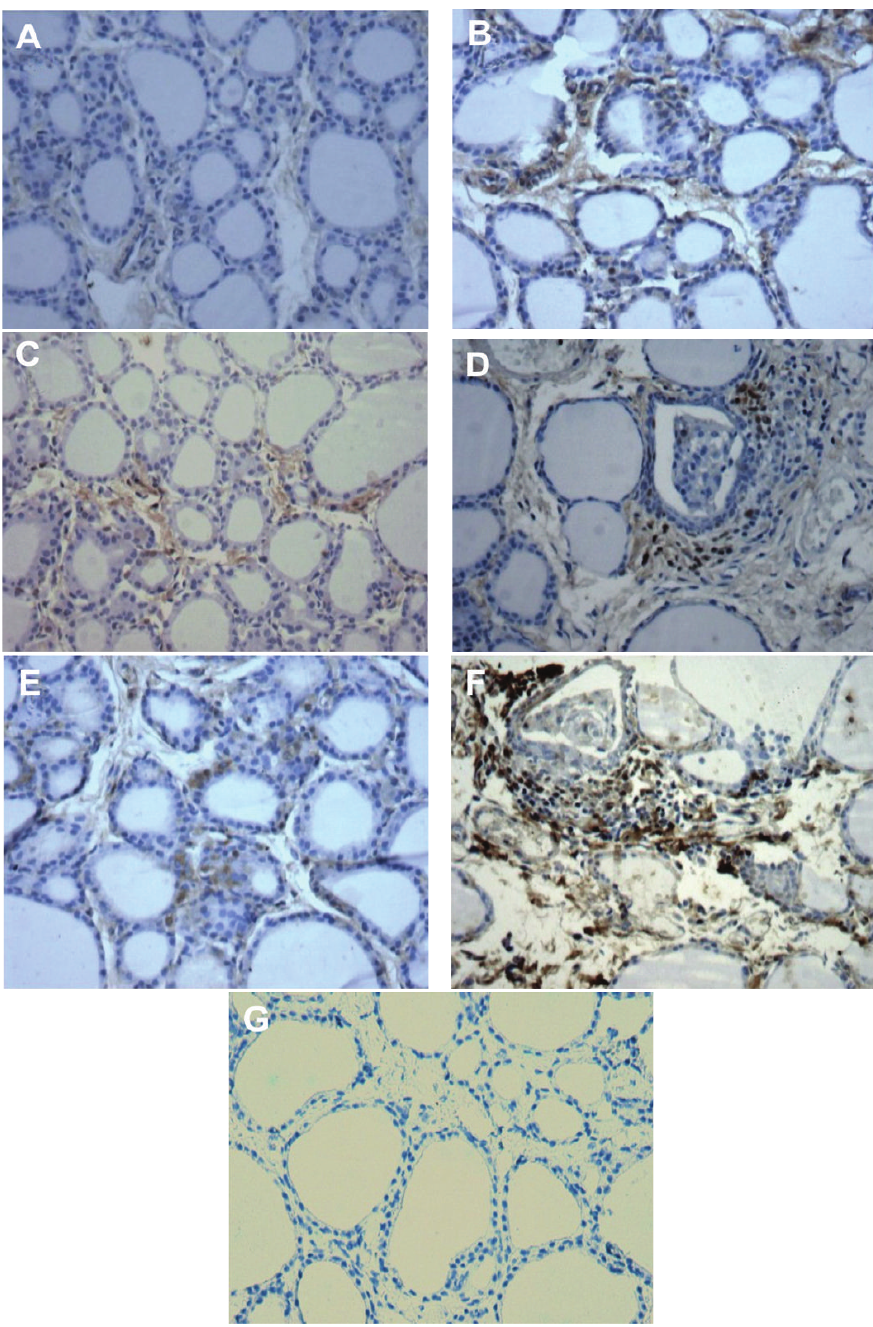
Figure 3: CD4 + T cell expression and localization in thyroid tissues from EAT rats. (A) Section of thyroid tissue from the normal group, showing absence of staining for CD4 + T cells. (B) Section of thyroid tissue from the TG group, showing immunostaining for CD4 + T cells in many mononuclear cells (yellowish-brown). (C) Section of thyroid tissue from the HI group. (D) Immunostaining for CD4 + T cells in many mononuclear infiltrating cells in the thyroid tissue from the HI+TG group. (E) Section of thyroid tissue from the HII group. (F) High immunoreactivity for CD4 + T cells in thyroid tissues from the HI group. (G) Section of thyroid tissue with negative control staining. Original magnification: